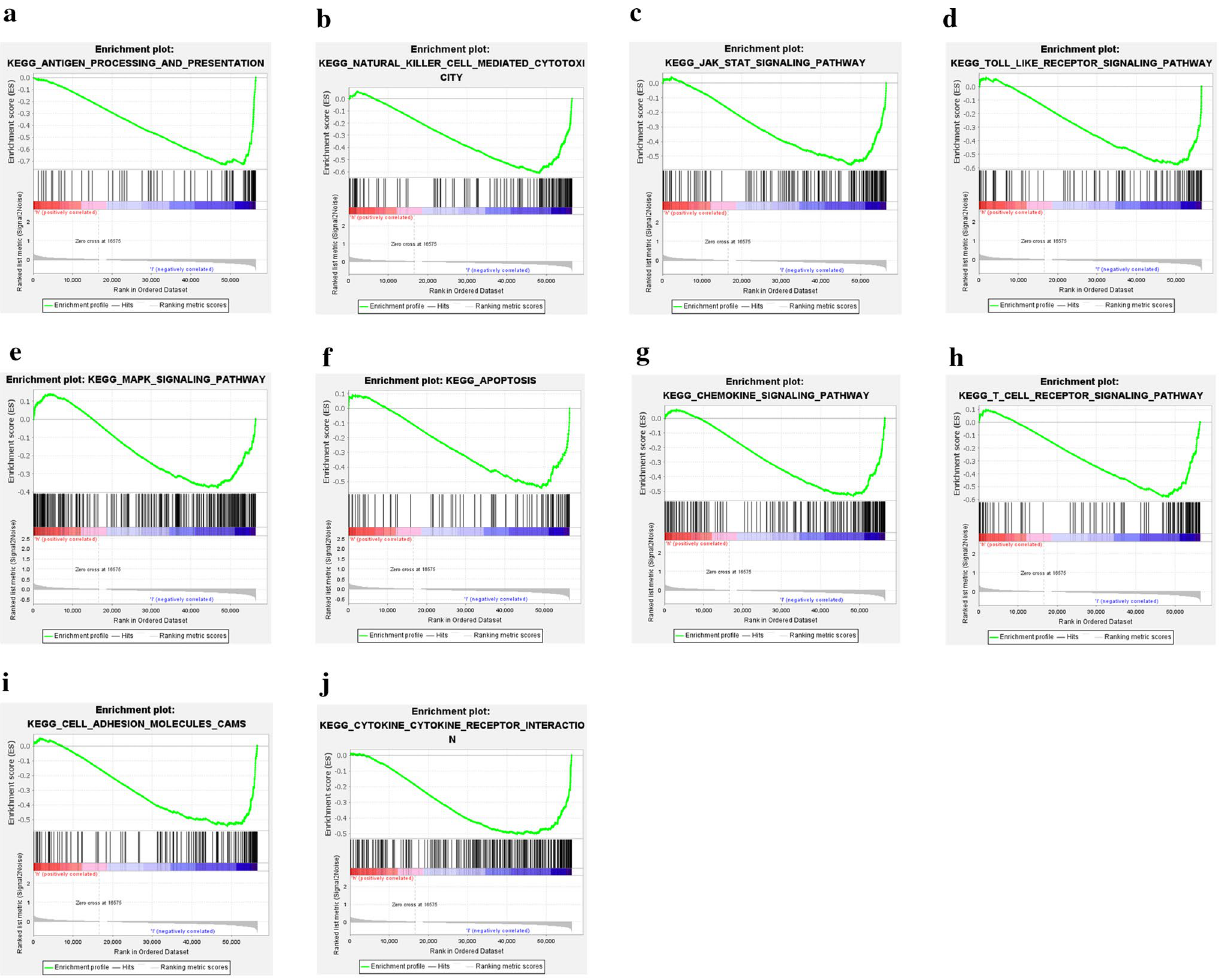
Fig. 5 Pathway enrichment analyses. Immune-related signaling pathways and processes were enriched in the low-risk group ( a – j ). All p < 0.05, FDR <